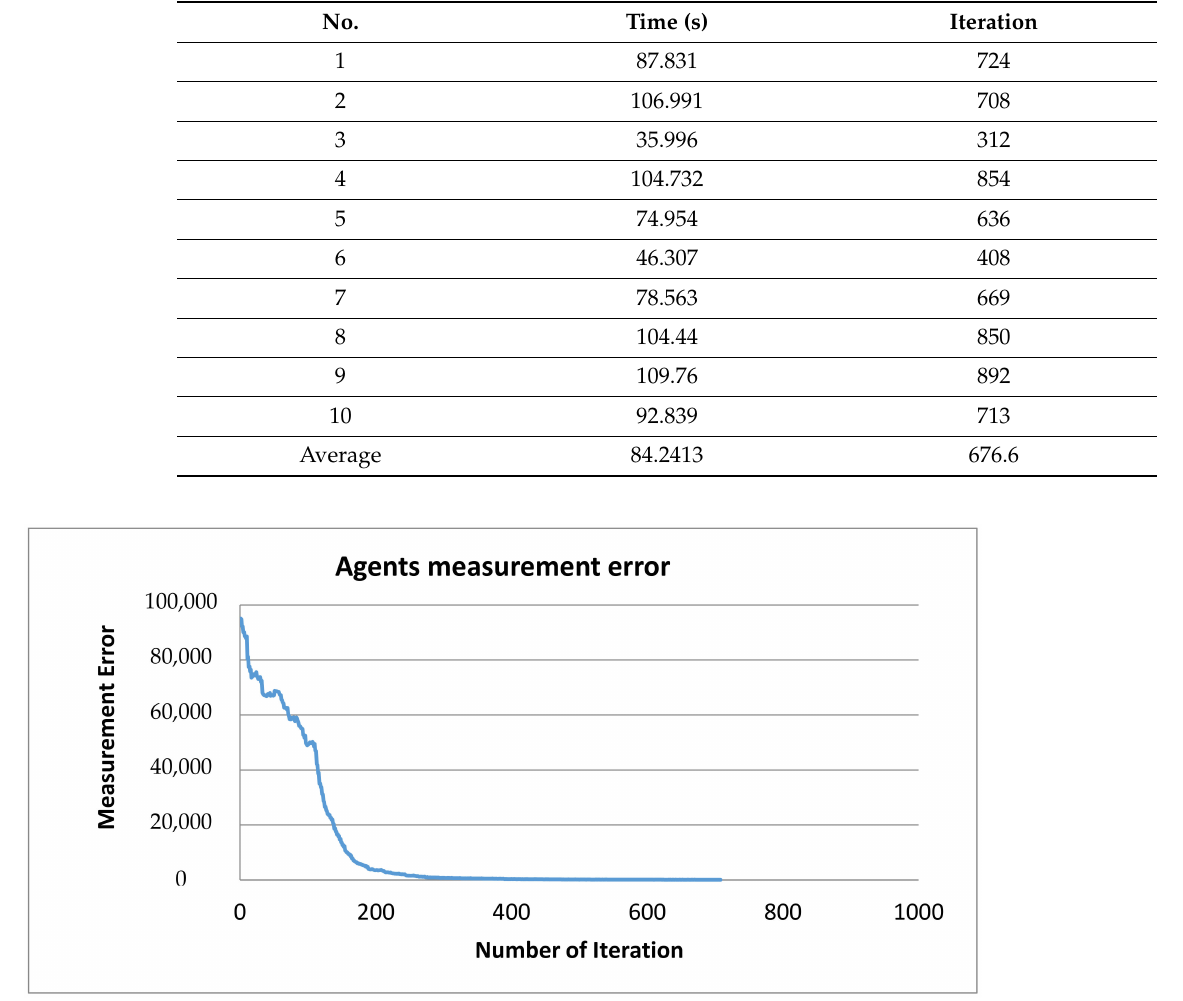
Figure 7. Agent measurement